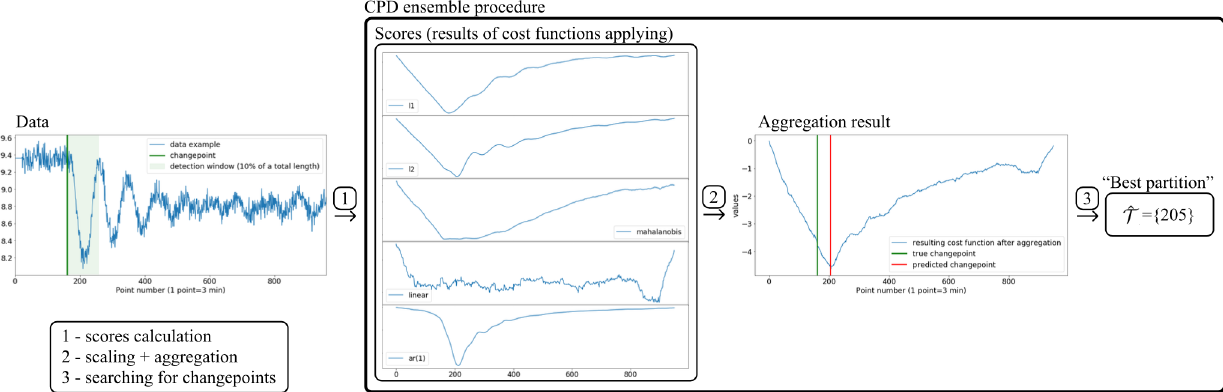
Figure 3. An illustrative example of the cost functions aggregation procedure.